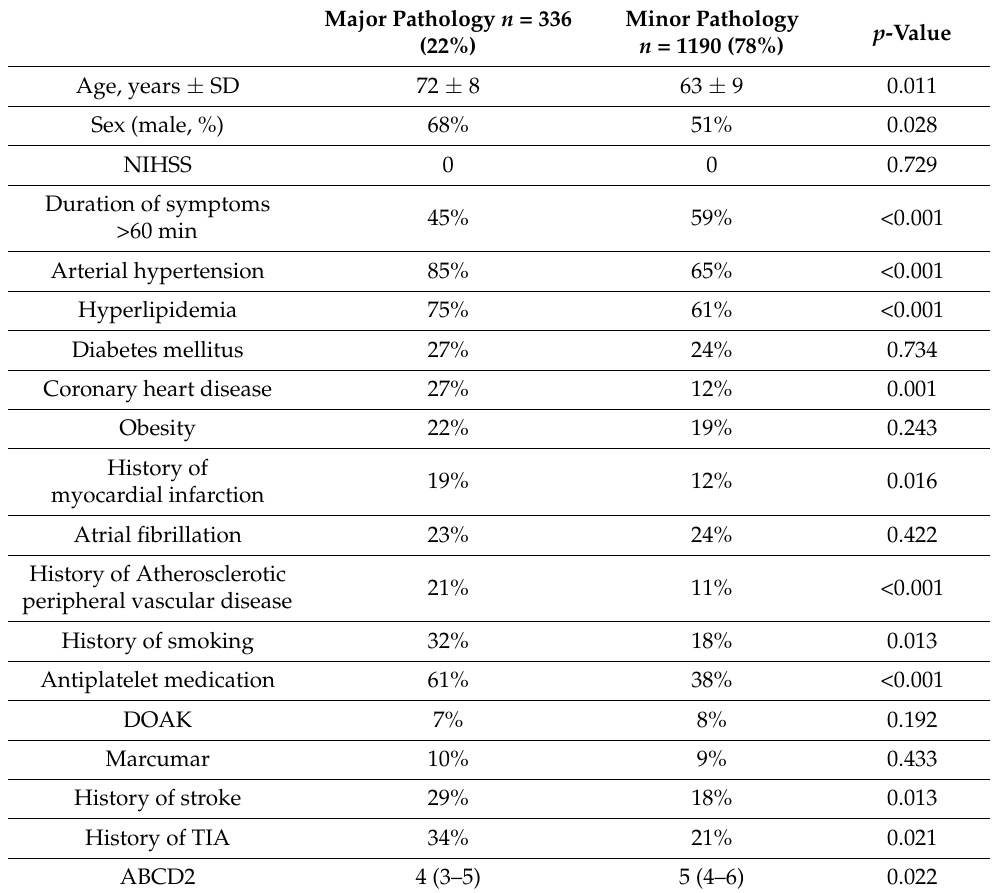
Table 1. Characteristics of patients with and without relevant vascular pathology in terms of gender, age, previous illnesses, risk factors, anamnesis, and medication. (NIHSS National Institutes of Health Stroke Scale; DOAK Direct Oral Anticoagulation; TIA Transient Ischaemic Attack; ABCD Age, Blood pressure, Clinical features, Duration of TIA, and presence of